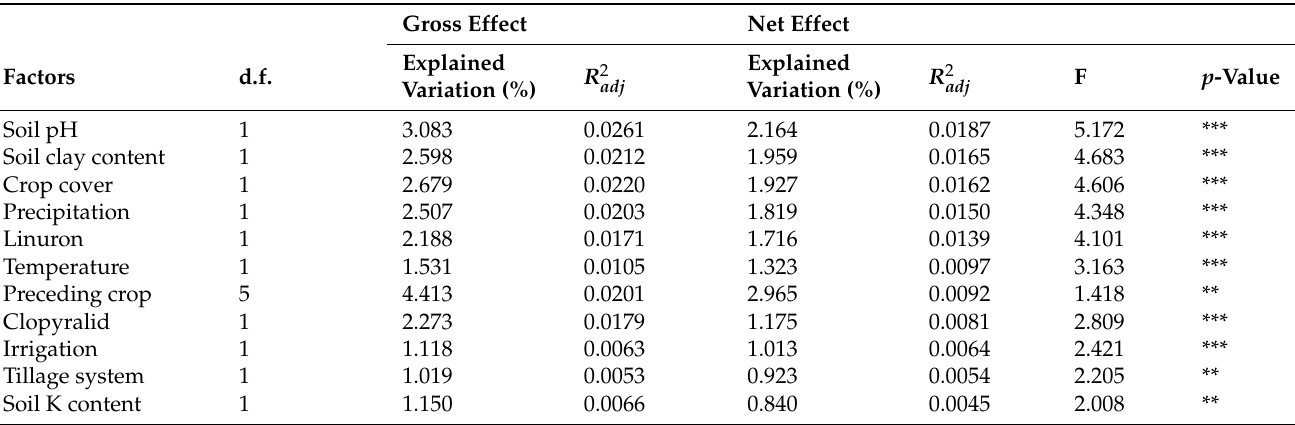
Figure 2. The mean cover values (% of the surface covered) and the frequency of occurrence (% of the fields surveyed) of the twenty most dominant/frequent weed species in the broad-scale survey (BS). Table 2. Gross and net effects of the explanatory variables on the weed species composition identified using (p)RDA analyses with single explanatory variables in the broad-scale survey